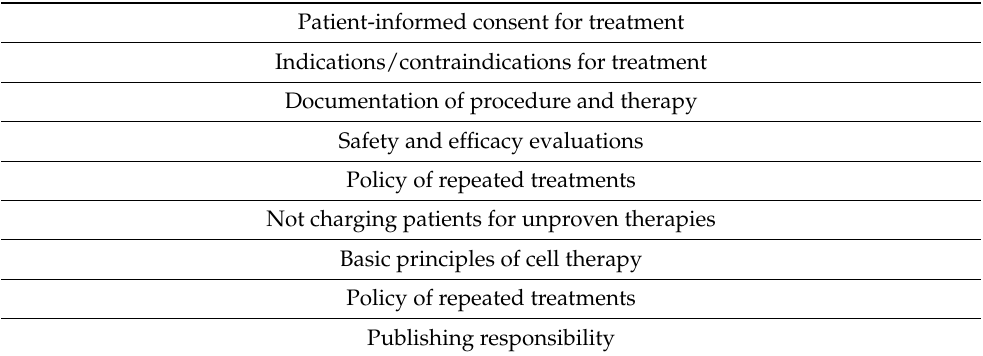
Table 4. Ethical requirements in ASD stem cell